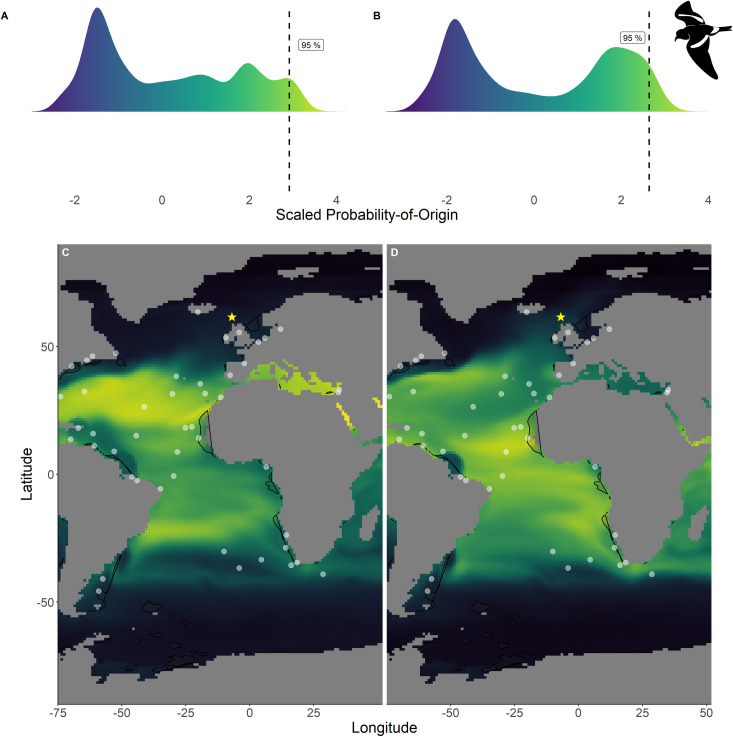
Scaled probability-of-origin maps based on δ13C and δ18O for each group of the Leach’s storm-petrel.Terminal nodes from a conditional inference tree (CIT) based on differences between years, and correlated to body morphology (Fig 1A) were treated as groups. (A) Scaled probability-of-origin value distribution for terminal CIT node 8; (B) scaled probability-of-origin value distribution for terminal CIT node 9; (C) scaled probability-of-origin map for terminal CIT node 8; (D) scaled probability-of-origin map for terminal CIT node 9. Scaled probability-of-origin values are shown on a relative high (yellow)–low (black) gradient in both the density plots and maps. The 95% quantile of the scaled probability-of-origin values per terminal CIT node are shown with the dashed line. Shaded contours show high chlorophyll-a concentration areas (upper 95% of the data), and white dots show observation locations [88, 89]. The yellow star indicates the location of the breeding colony where birds were sampled.